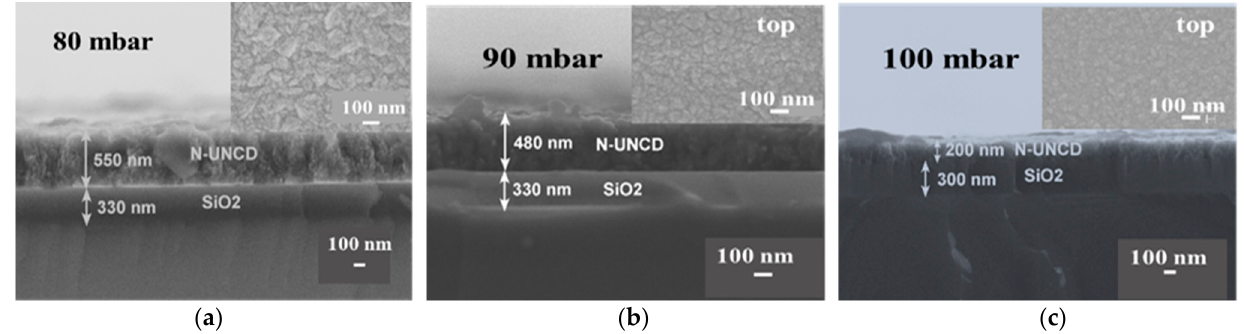
Figure 2. SEM top view and cross section images of N-UNCD films grown at: ( a ) 80 mbar and 4500 W, ( b ) 90 mbar and 4500 W, ( c ) 100 mbar and 4500 W.